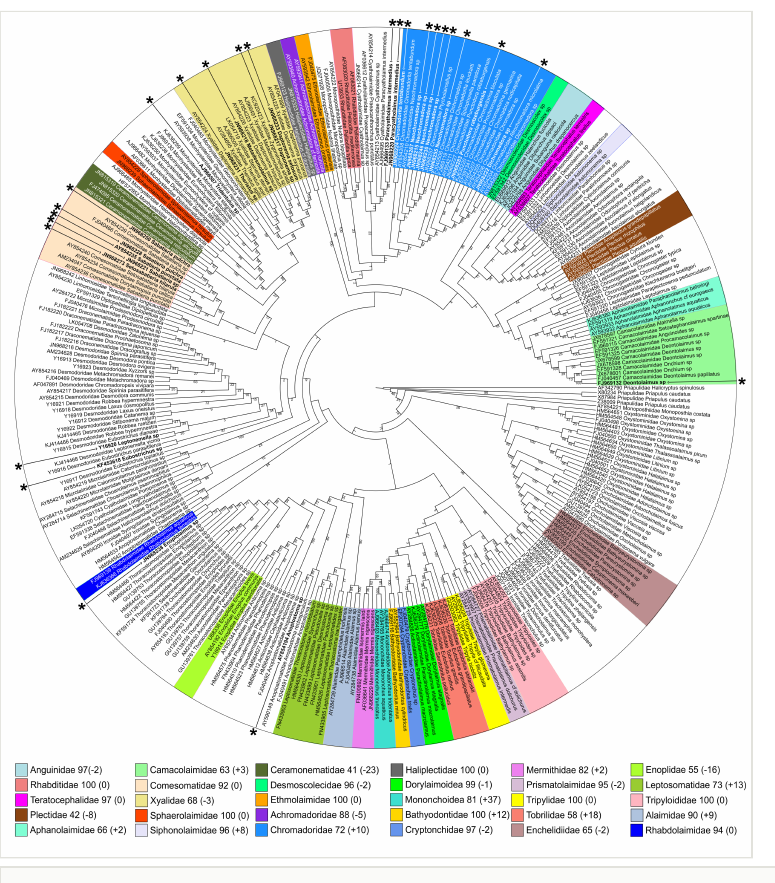
Figure 2. "Worst case" scenario – Maximum likelihood tree inferred using Clustal-O-based alignment of the complete dataset and 25 additional sequences (marked by asterisks). Numbers after family names in the legend indicate current bootstrap support for each clade and di ff erence (in parenthesis) comparing to the original analysis (Clustal-O-based alignment, Maximum likelihood phylogeny inference, complete dataset) from the section 1.2 of the Out of 25 added sequences, only 18 could be assigned to family-level categories based on their clustering withing monophyletic clades Table 6. Only nine of them are placed in clades that receive high ( ≥ 70%) bootstrap support, namely clades equivalent to the families Comesomatidae and Xyalidae. The remaining nine are placed within clades equivalent to